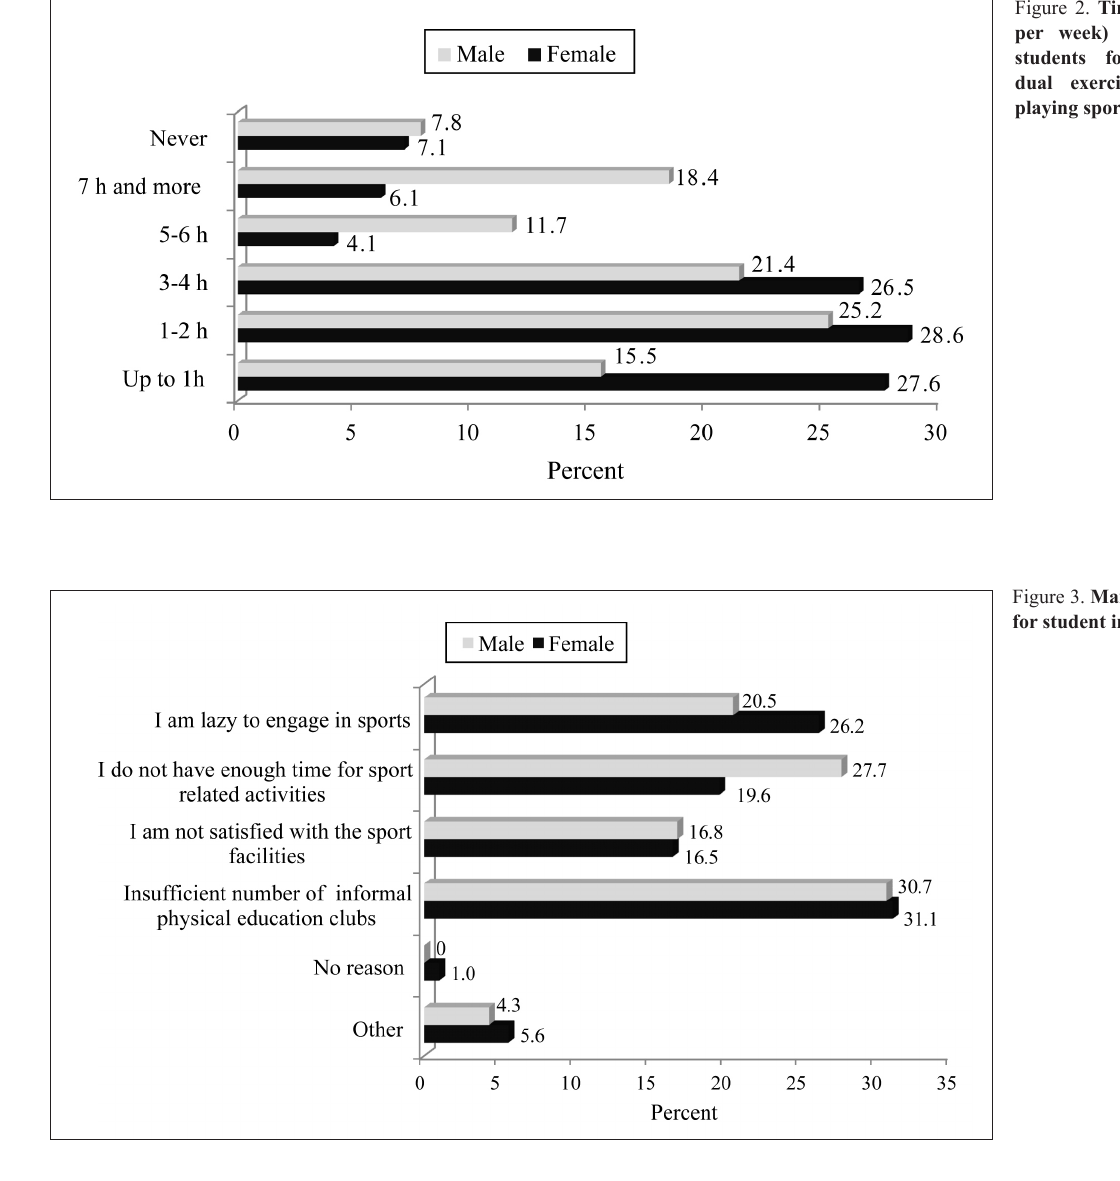
Figure 4. Students’ opinions related to the status of physical edu- cation